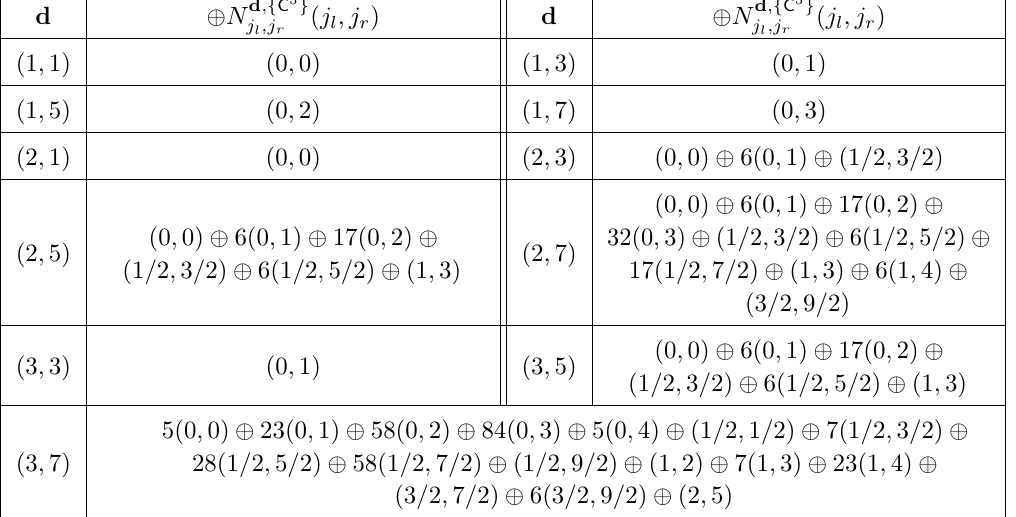
for the curve class d 1 m 0 + d 2 φ with d 1 ≤ 3 BPS , { C 5 }